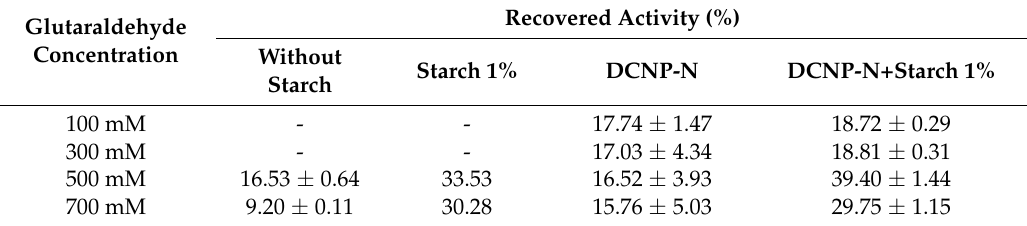
Table 3. Comparison of the effect of glutaraldehyde concentration on the recovered activity of CLEAs (without and with DCNP-N a ) synthesized in the presence of 1% ( w / v ) starch. Synthesis conditions: 16 h precipitation/crosslinking under static conditions in an ice bath, mass ratio protein/DCNP-N of